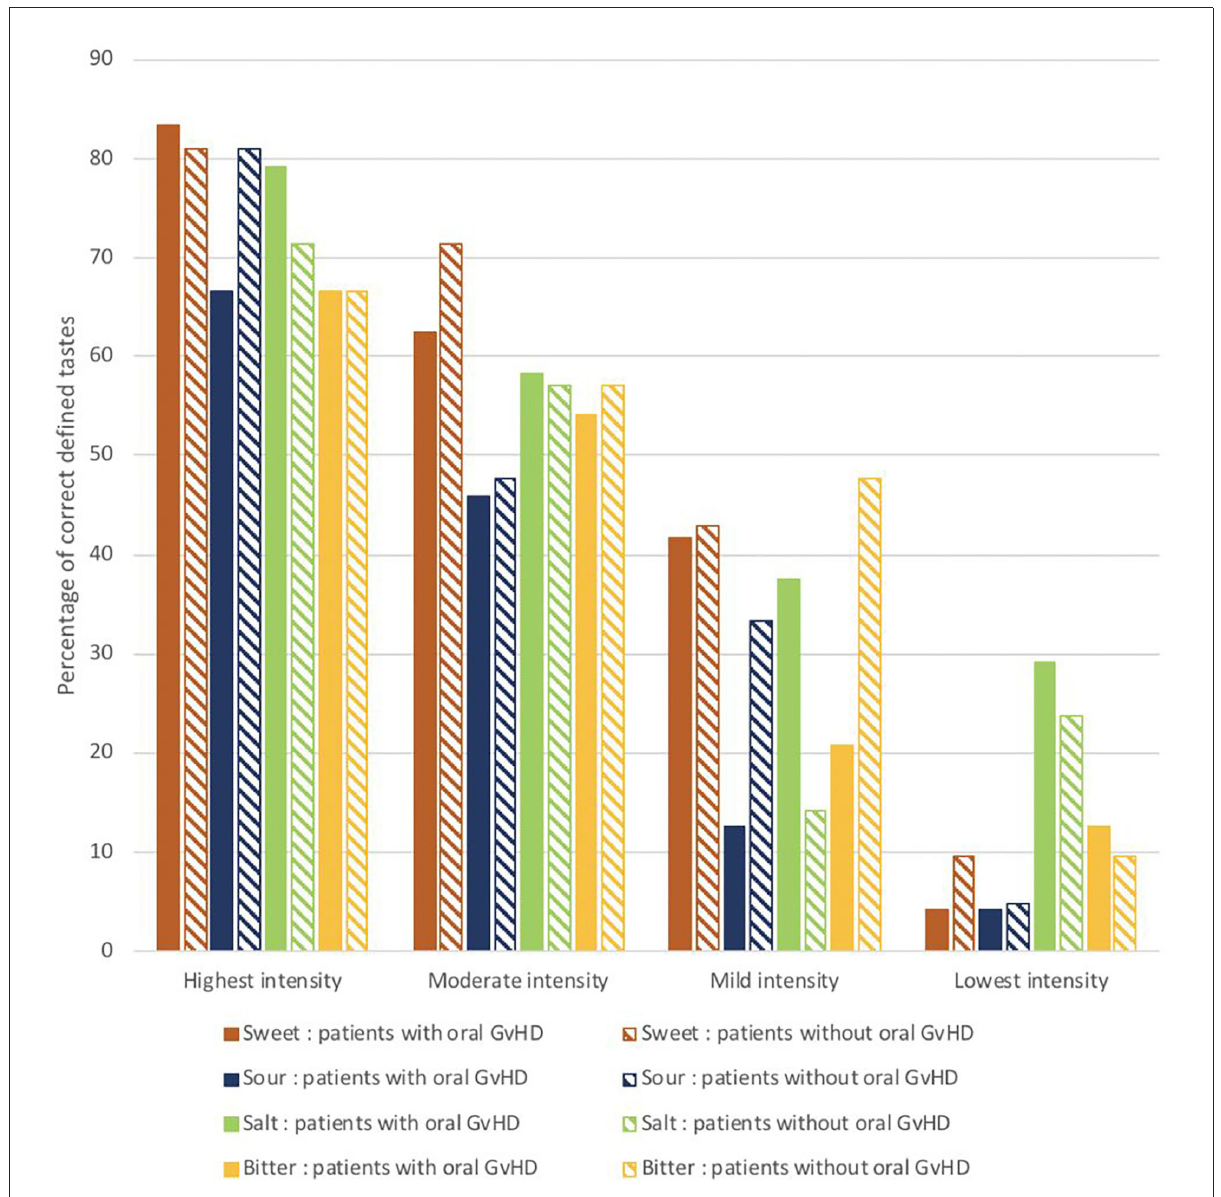
FIGURE1 The percentages of correctly identified tastes at different test concentrations in the clinical taste evaluation test conducted in patients with oral mucosal cGVHD vs. those without oral mucosal cGVHD ( N = 45).